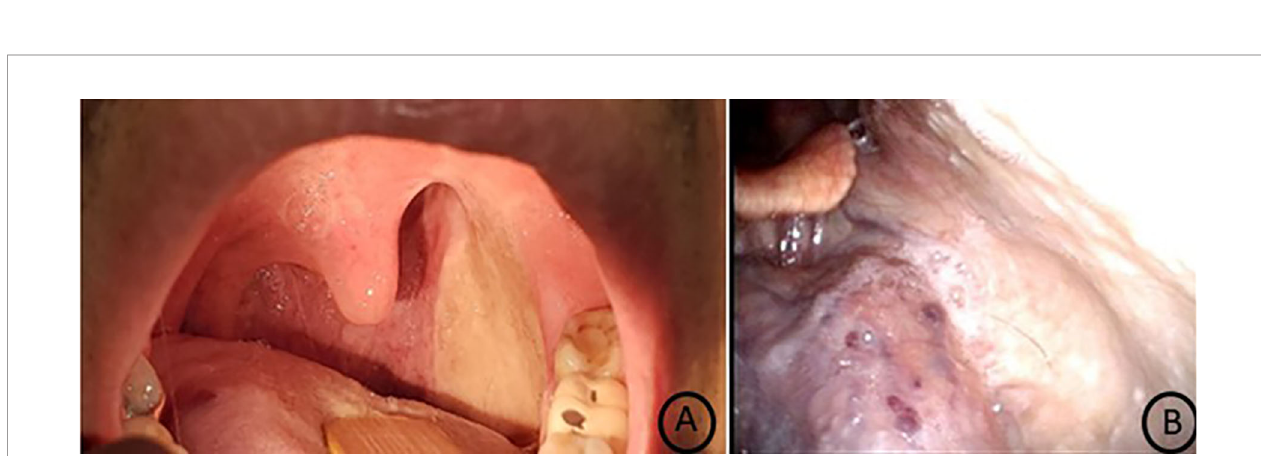
FIGURE 1 | Illustration of the surgical approach. (A) The submental island fl ap was designed and performed. (B) The neck dissection was performed. (C) After the neck dissection, the parapharyngeal space was exposed. (D) The tumor was exposed and dissected via the transoral approach. (E) The defection was reconstructed with the submental island fl ap.